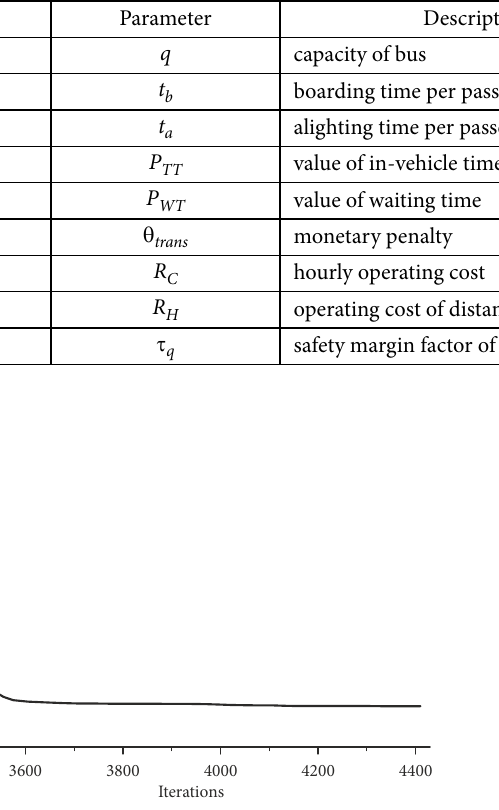
Figure 3. A solution convergence process corresponding to the 2nd column scenario in